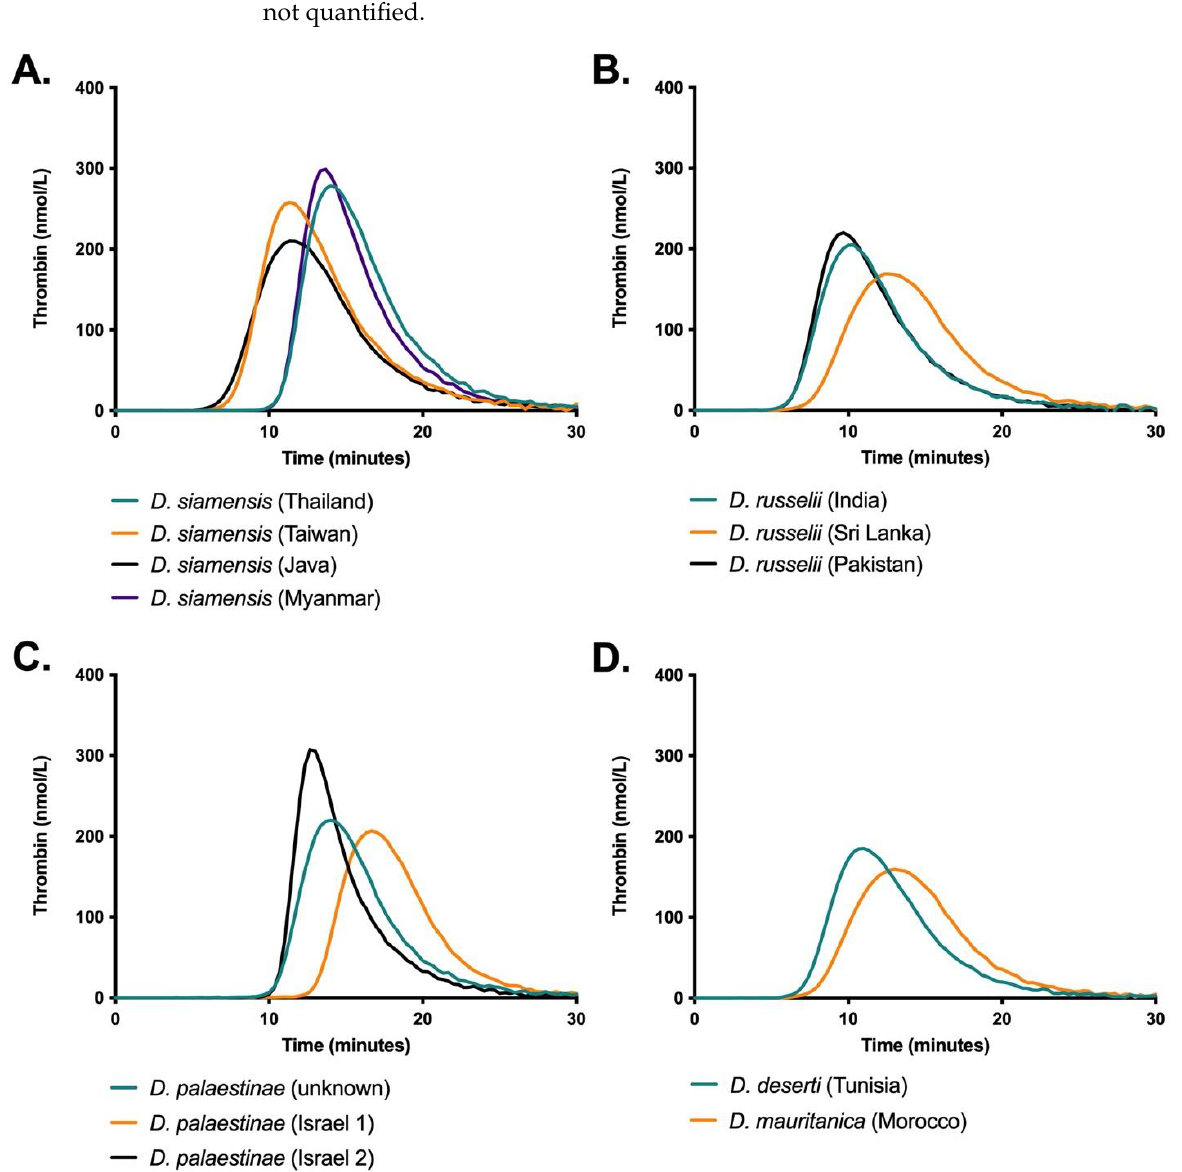
Figure 6. Real-time thrombin generation (nmol/L) by Daboia venoms (83 pg/mL) in human plasma, incubated at 37 ◦ C for 30 min, measured by Calibrated Automated Thrombinoscope (CAT). Data are the mean of three replicates (traces are the automatic output of CAT software in which data are automatically calculated and errors bars omitted).